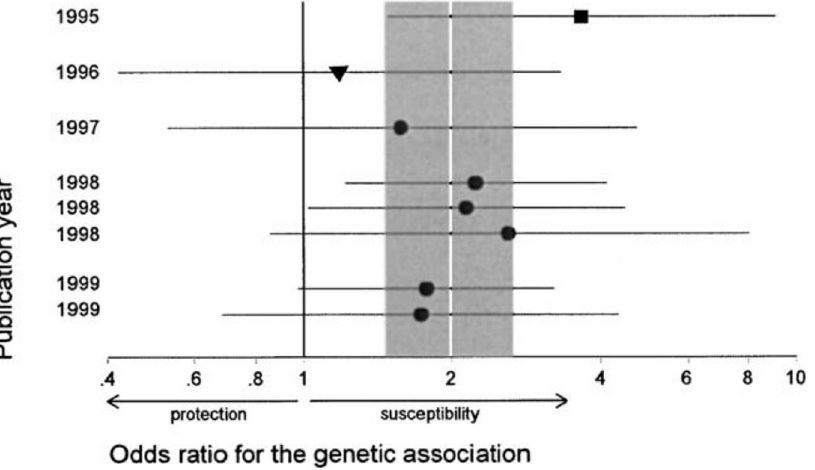
Figure 1. Illustration of Proteus phenemonen from Ioannidis and Trikalinos [ 27 ] . (Reprinted from Journal of Clinical Epidemiology, Vol. 58, J. P. Ioannidis and T. A. Trikalinos, Early extreme contradictory estimates may appear in published research: The Proteus phenomenon in molecular genetics research and randomized trials, pp. 543–549, 2005, with permission from Elsevier.) The figure shows odds ratios and 95% confidence intervals of ‘‘the relationship between the methylenetetrahydrofolate reductase (MTHFR) TT genotype in the mother and the risk of neural tube defects in the child’’. The study with the strongest effect is shown by a square symbol and the study with the smallest effect is shown by a triangular symbol. The white line represents the summary odds ratio. The shaded area represents the 95% confidence interval of the summary odds